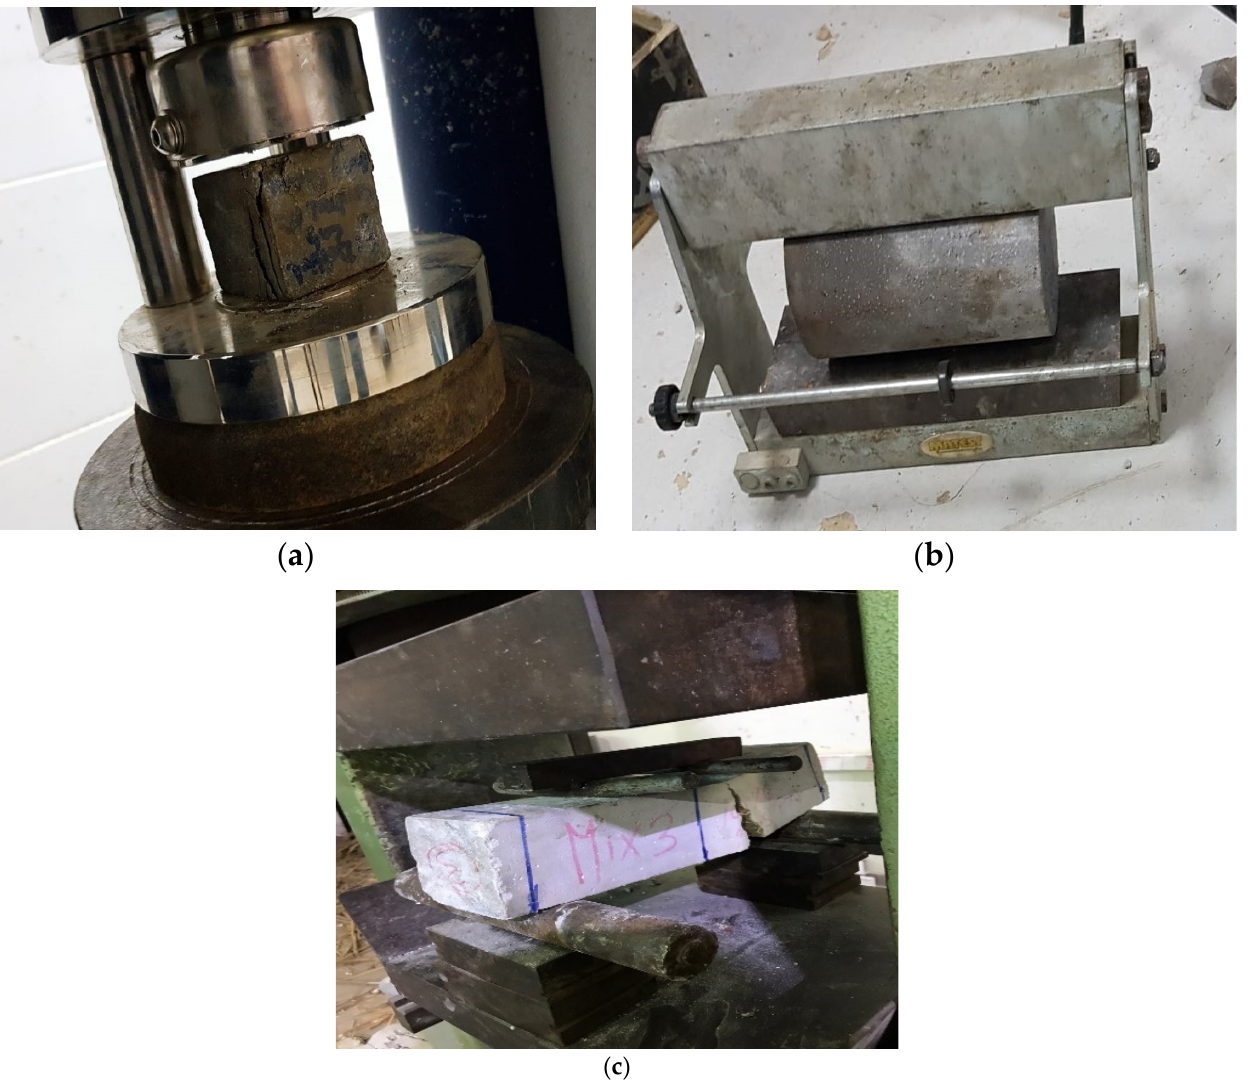
Figure 5. Mechanical testing: ( a ) compressive strength; ( b ) split tensile strength; ( c ) fl exural strength.